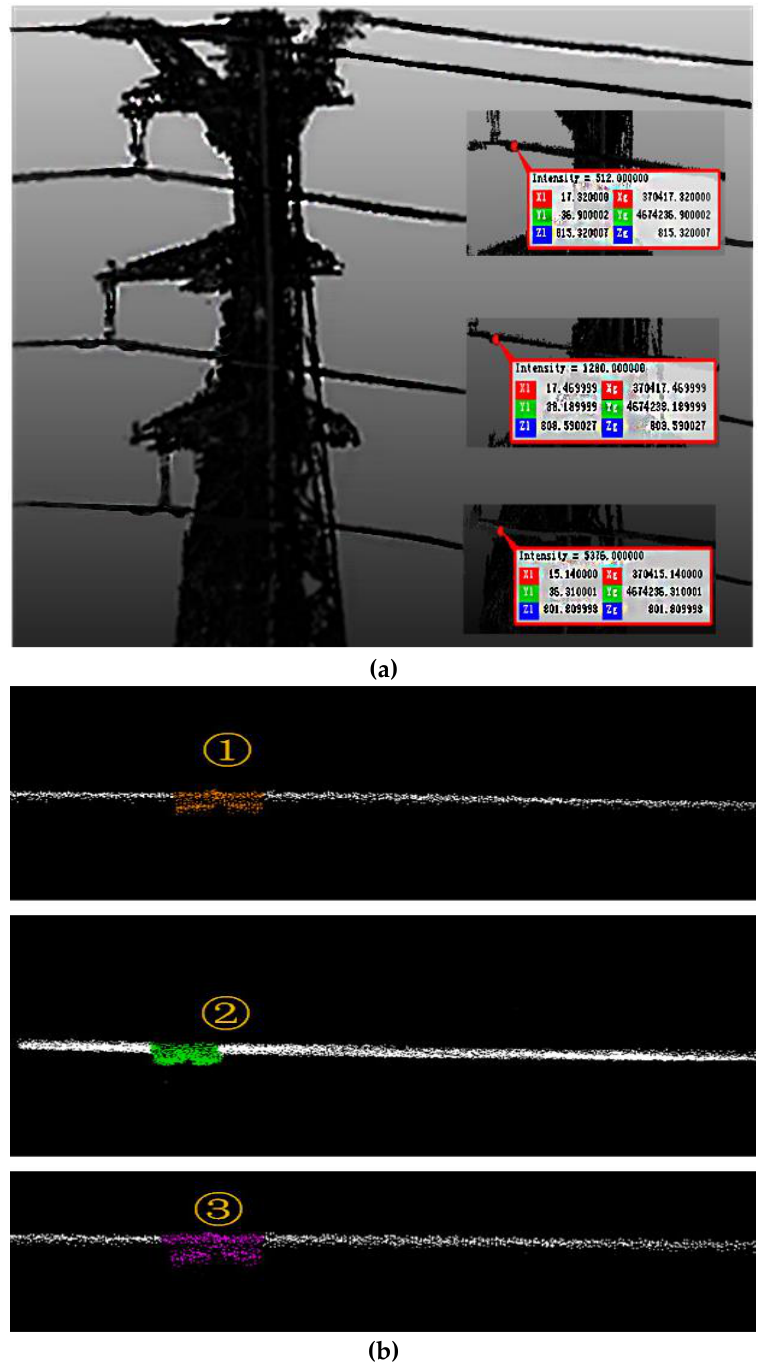
Figure 21. Point cloud results: ( a ) The point cloud; ( b ) the classification results.